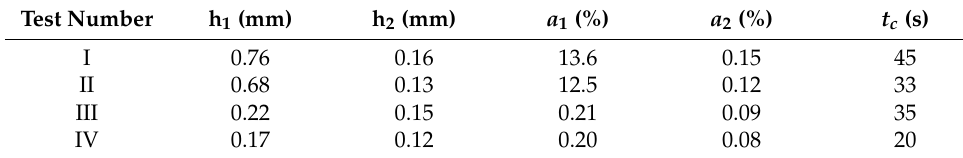
Table 3. Section parameters and separation time of the GCr15 steel